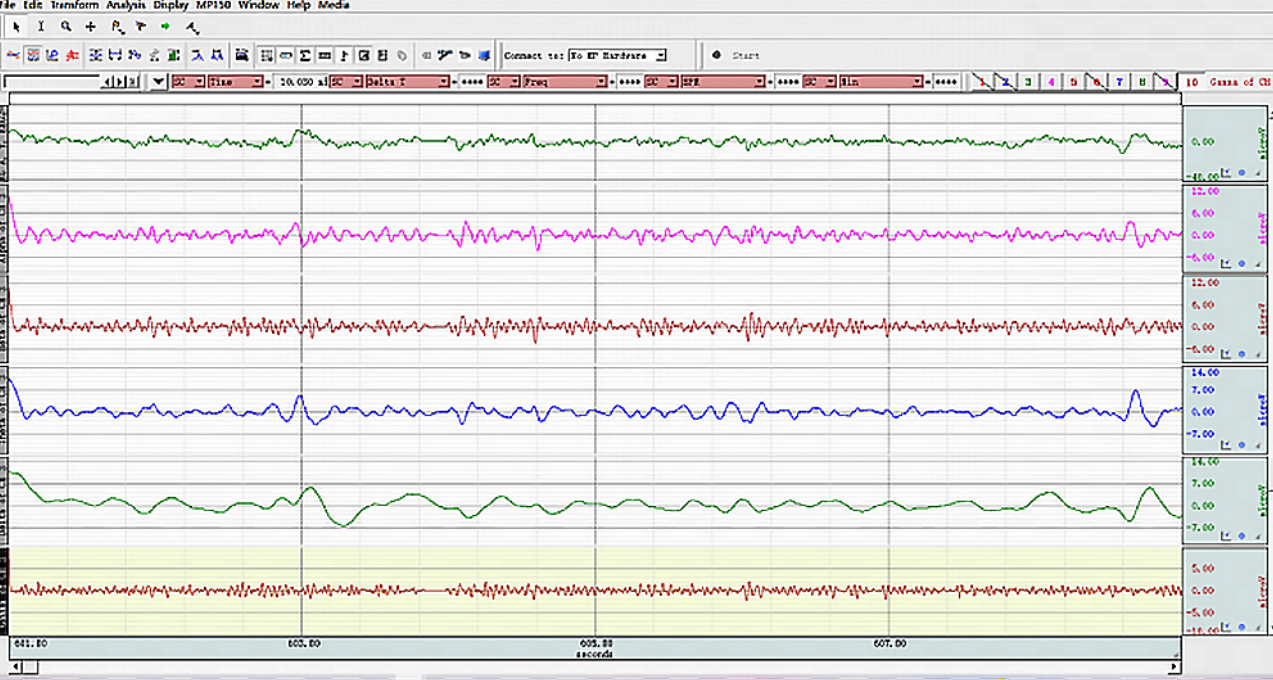
Figure A1. Example of waves in different bands filtered by